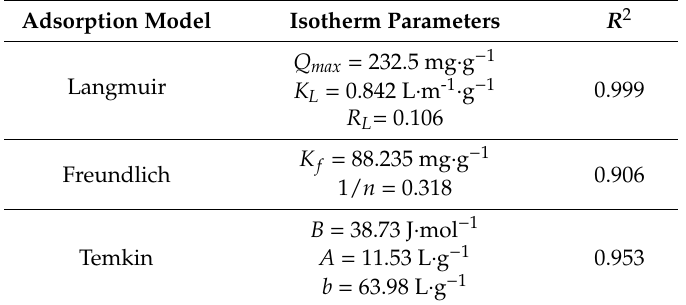
Figure 10. ( a ) Langmuir, ( b ) Freundlich, and ( c ) Temkin isotherm plots for adsorption of MB on SLS-C. Table 4. Isotherm parameters of the Langmuir, Freundlich, and Temkin